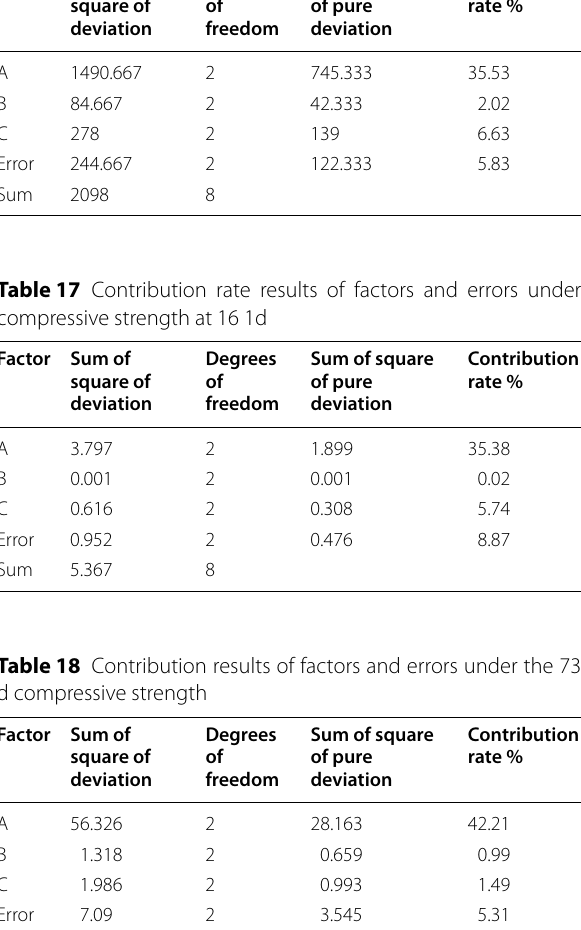
Table 16 Results of the contribution rate of factors and errors under mortar fluidity Factor Sum of square of